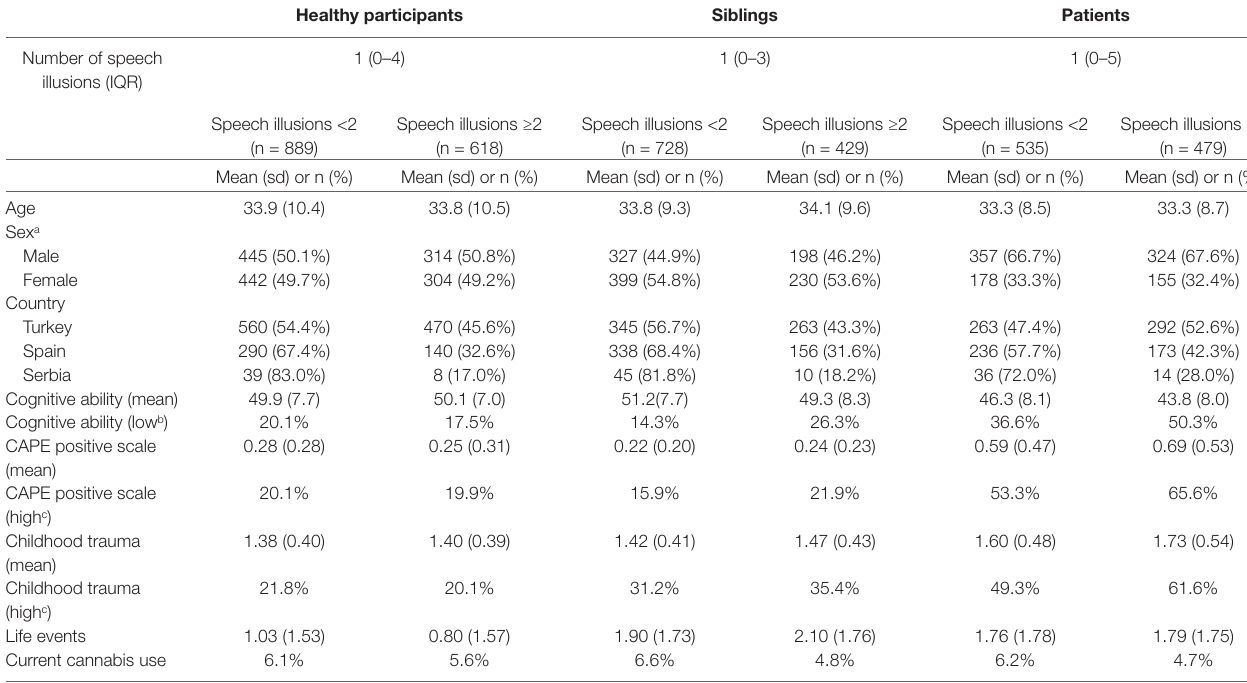
TABLE 1 | Summary of selected sociodemographic